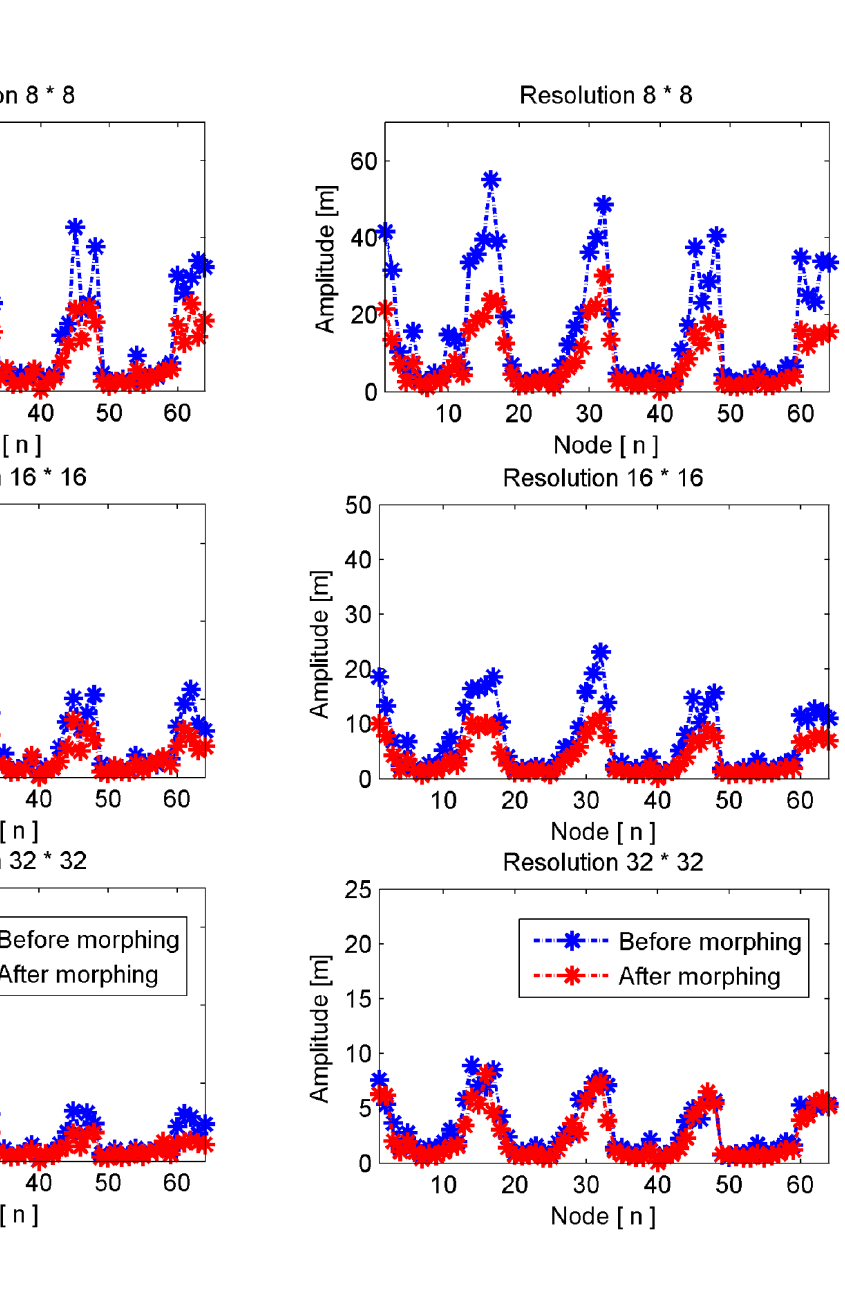
Figure 6. Comparison between the maximum world-space error before and after applying the algorithm.